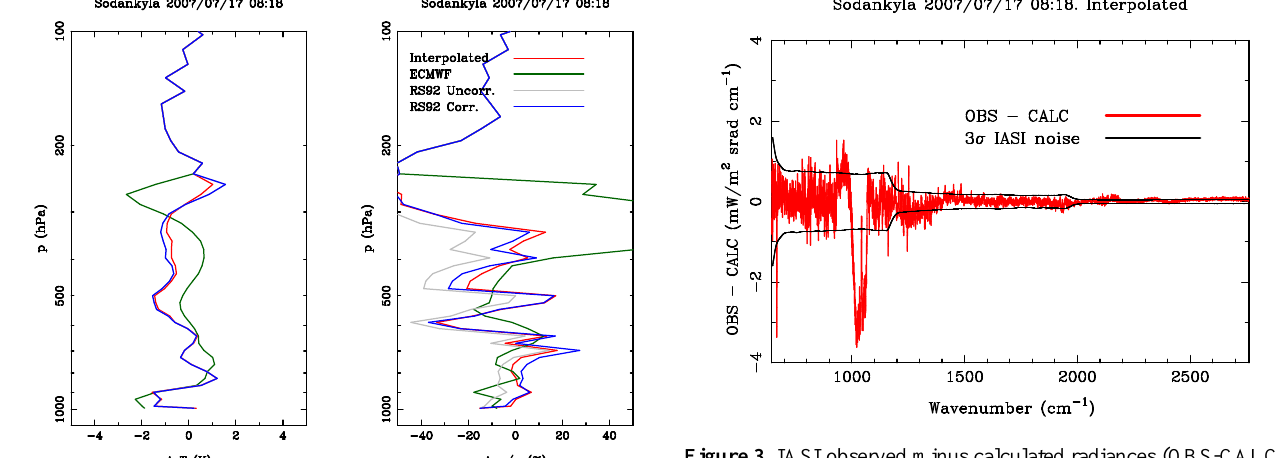
Figure 3. IASI observed minus calculated radiances (OBS-CALC) for the “Interpolated”